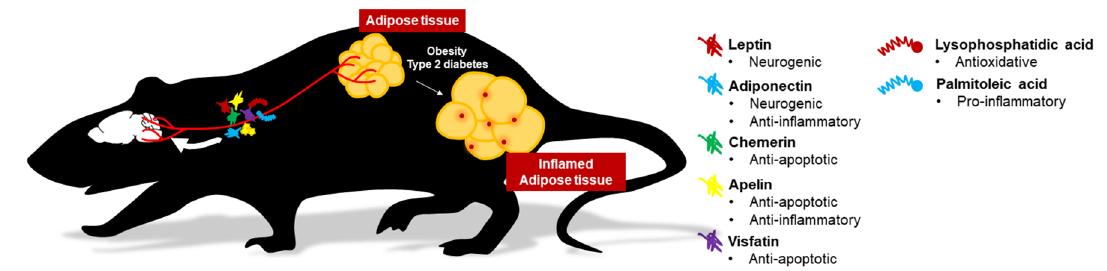
Figure 1. Potential mechanism of adipokine actions on brain health. Adiponectin and leptin can cross the blood–brain barrier to promote neuroplasticity. Other adipokines and lipokines show profound effects on mediating neurogenic and neuroinflammatory mechanisms.